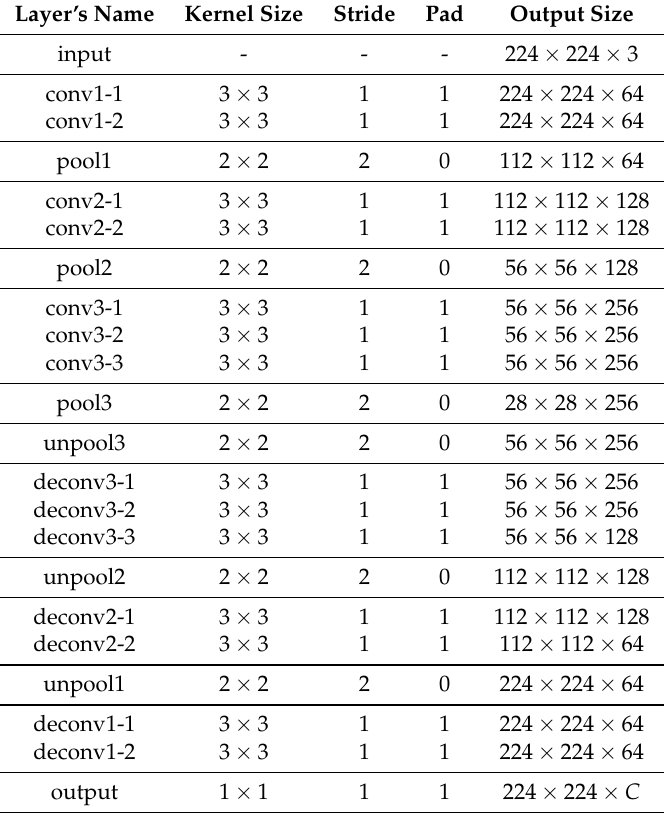
Table 1. Detailed structure of proposed light-weight network architecture. Note that C is the number of